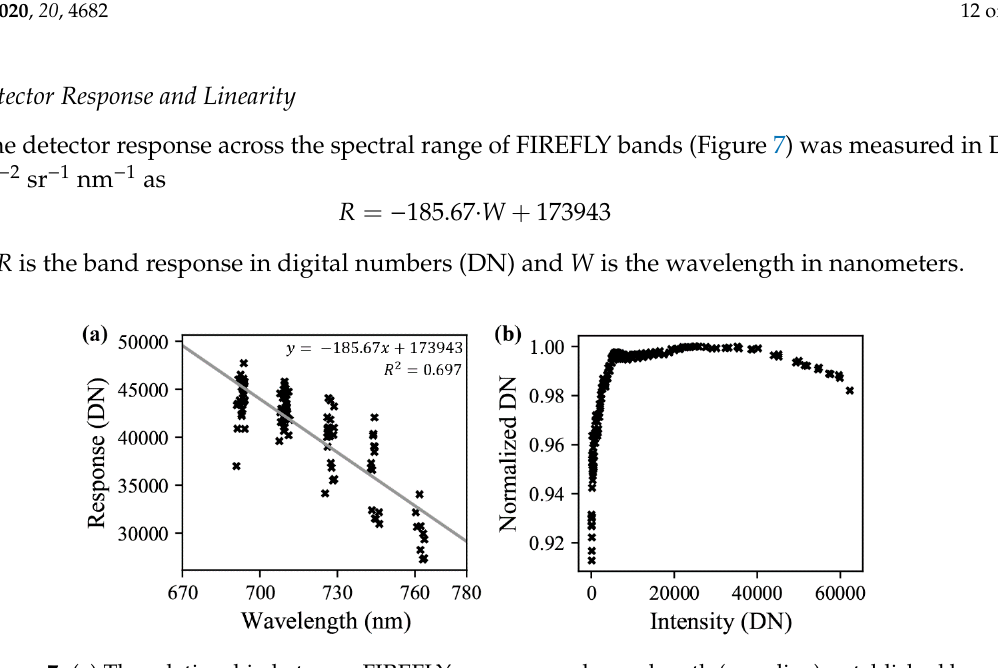
Figure 7. ( a ) The relationship between FIREFLY response and wavelength (gray line), established by GLAMR observations (black x); ( b ) the relationship between normalized digital numbers (DN) and intensity DN used to establish the detector non-linearity, as measured with the GLMR integrating sphere monitors and ASD (black x).